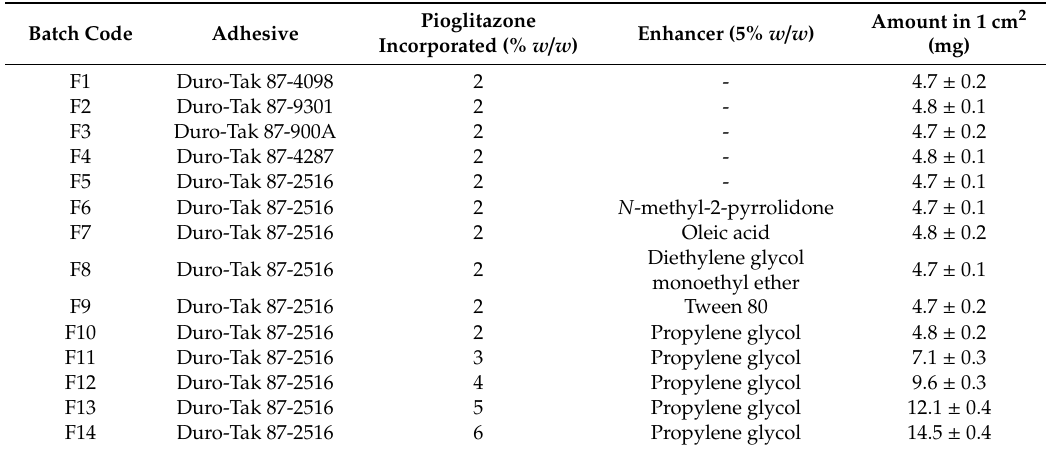
Table 1. Composition of prepared patches and the drug